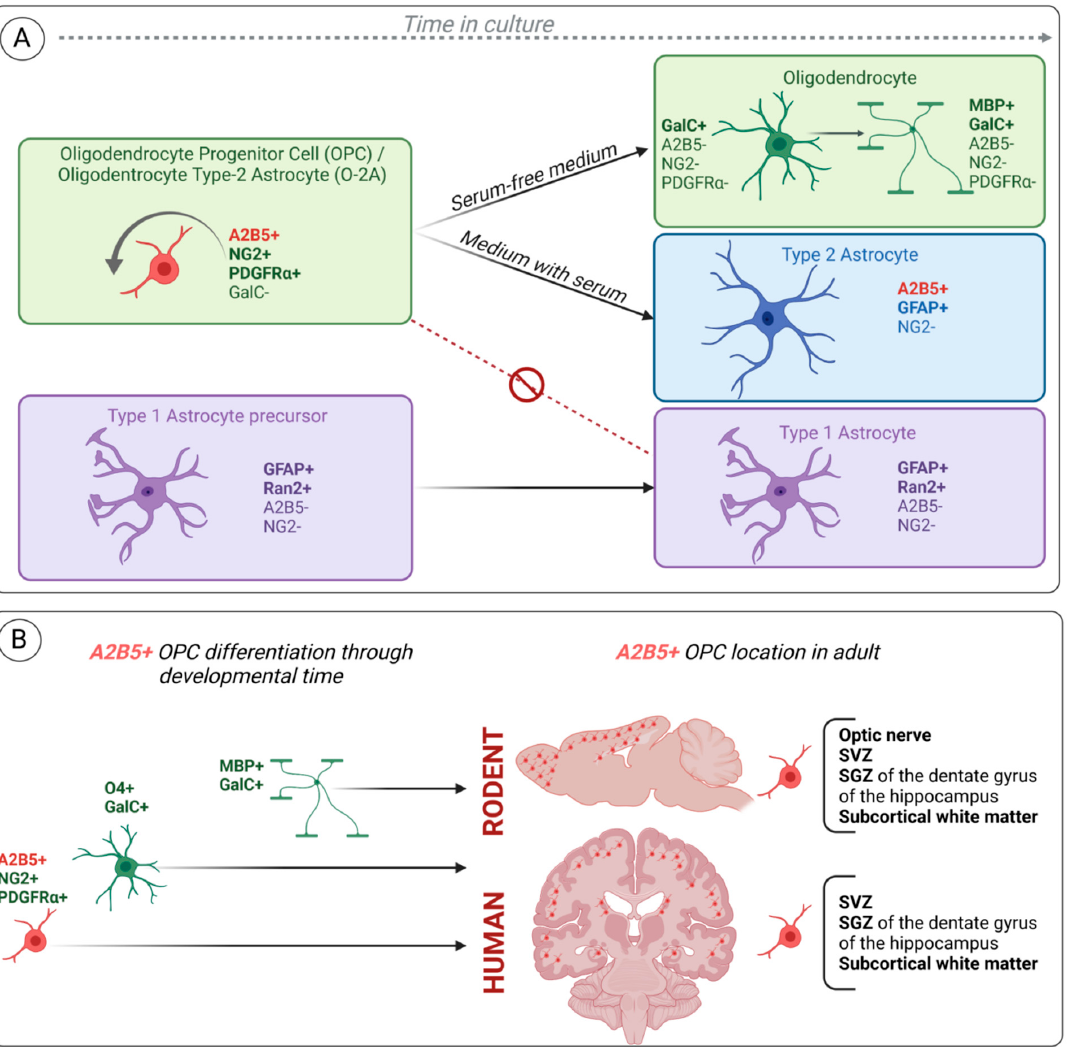
Figure 3. Schematic representation of the oligodendroglial lineage markers highlighted in vitro ( A ). A2B5+ OPC differentiation through developmental time and its location in adult ( B ). ( A ) Oligoden ‐ drocyte precursor cells (OPC), also known as oligodendrocyte type ‐ 2 astrocyte progenitor cells (O ‐ 2A), are characterized by A2B5, NG2 and PDGFR α expression. In serum ‐ free medium, A2B5+ OPCs/O ‐ 2A differentiate into GalC+ oligodendrocytes while losing A2B5, NG2 and PDGFR α as they differentiate. These oligodendrocytes can further differentiate to expressing myelin basic protein (MBP), but they never achieve a full mature myelinating oligodendrocyte phenotype. In the pres ‐ ence of serum, OPCs/O ‐ 2A differentiate into type ‐ 2 astrocytes characterized by A2B5 and GFAP co ‐ expression. However, type ‐ 1 astrocyte precursors defined by the lack of A2B5 are not generated from OPC/O2A and differentiate into A2B5 ‐ GFAP+ type ‐ 1 astrocyte. They represent a different lin ‐ eage. ( B ) A2B5+ OPCs/O ‐ 2A differentiate through developmental time into immature (O4+, GalC+) and mature (MBP+, GalC+) oligodendrocytes while losing A2B5 marker. Nevertheless, in adult ‐ hood, A2B5+ OPCs/O ‐ 2A persist in specific neurogenic areas and subcortical white matter of rodent and human brains. SVZ: subventricular zone; SGZ subgranular zone. 2.4. A2B5 and Other OPC Cell Surface Markers: NG2 and PDGFR α Although A2B5 was the first ‐ discovered OPC cell surface marker shown to be highly relevant for labelling cells in culture, it appears that it was technically difficult to use it for immunohistochemical detection in routinely processed tissue section. Because OPCs pro ‐ liferate in response to PDGF α , it was subsequently demonstrated that OPCs express